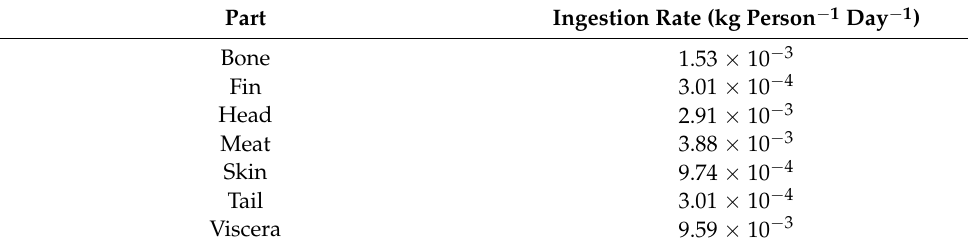
Table 3. Estimated ingestion rate of various parts of Tilapia spp.